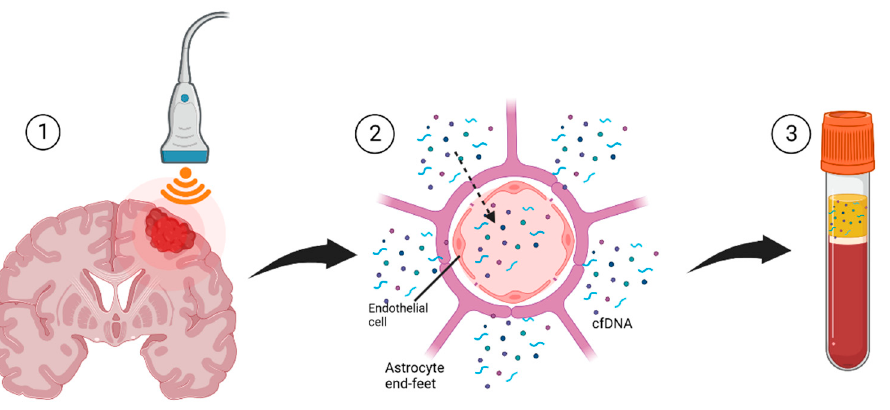
Figure 3. Depiction of the steps for FUS liquid biopsy. ( 1 ) FUS is used to target the brain tumor in a precise region of interest; ( 2 ) Oscillation of microbubbles produces acoustic cavitations that cause transient opening of the BBB and release of biomarkers across the endothelial cells lining the BBB; ( 3 ) The biomarkers diffuse into the peripheral circulation and are collected in a blood draw for analysis. ( 3 ). Created with BioRender.com.